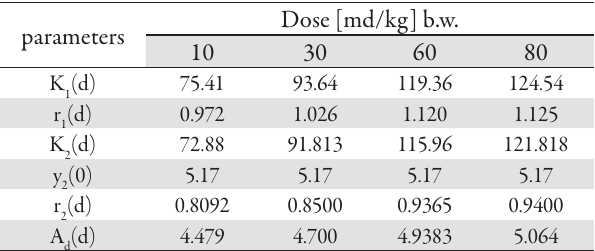
Tab. 2. Identification parameters for Eq.